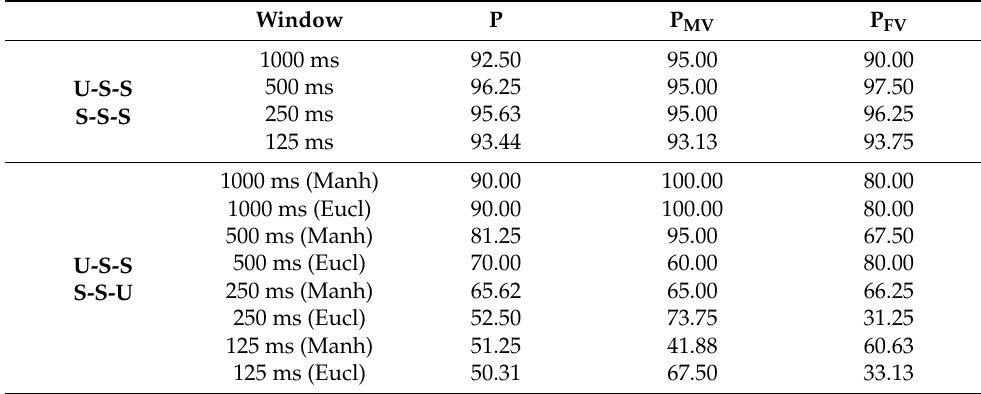
Table 7. Classification performances for MF scheme.